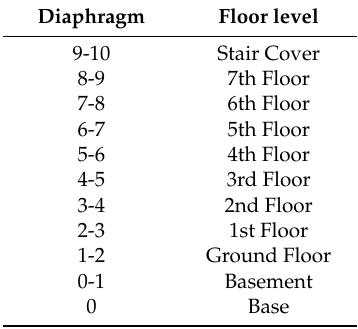
Figure 8. Pushover curves for the building. Table 1. Configuration of diaphragm for FE analysis.